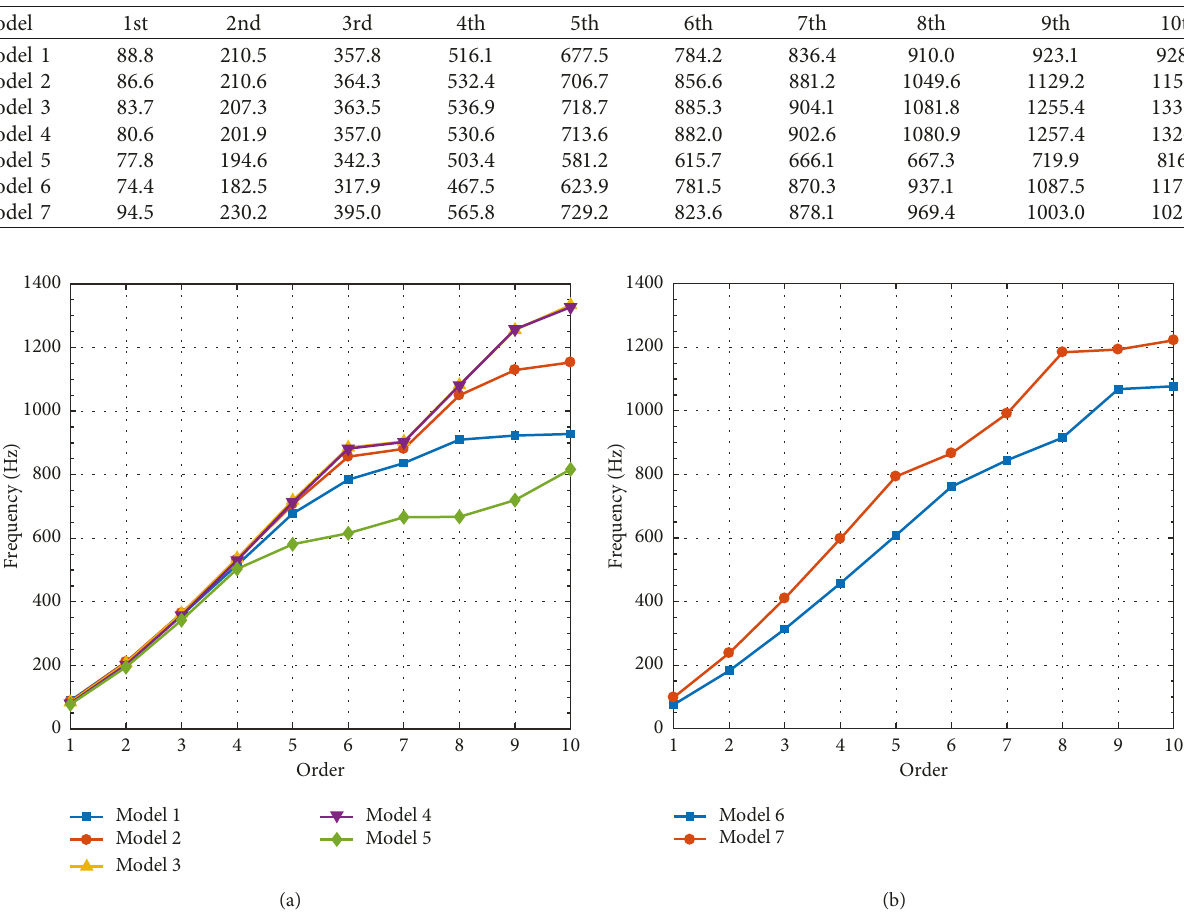
Figure 7: The first ten natural frequencies of the considered (a) uniform and (b) gradient DAH sandwich